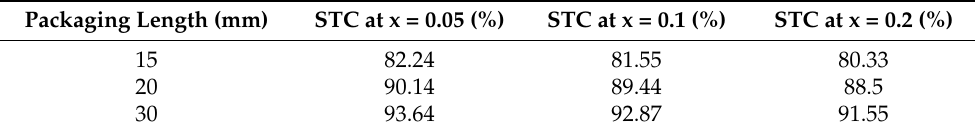
Table 8. Variation of strain-transfer coefficient (STC) with packaging length.